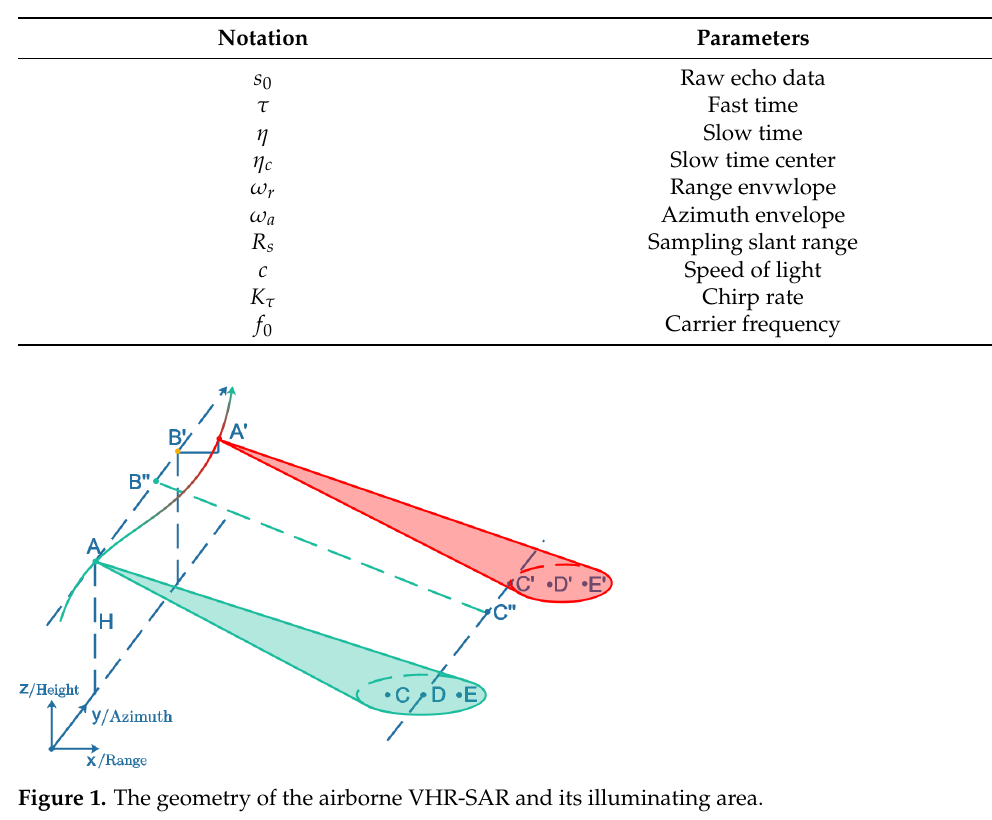
Table 1. Represented parameters of the notations.